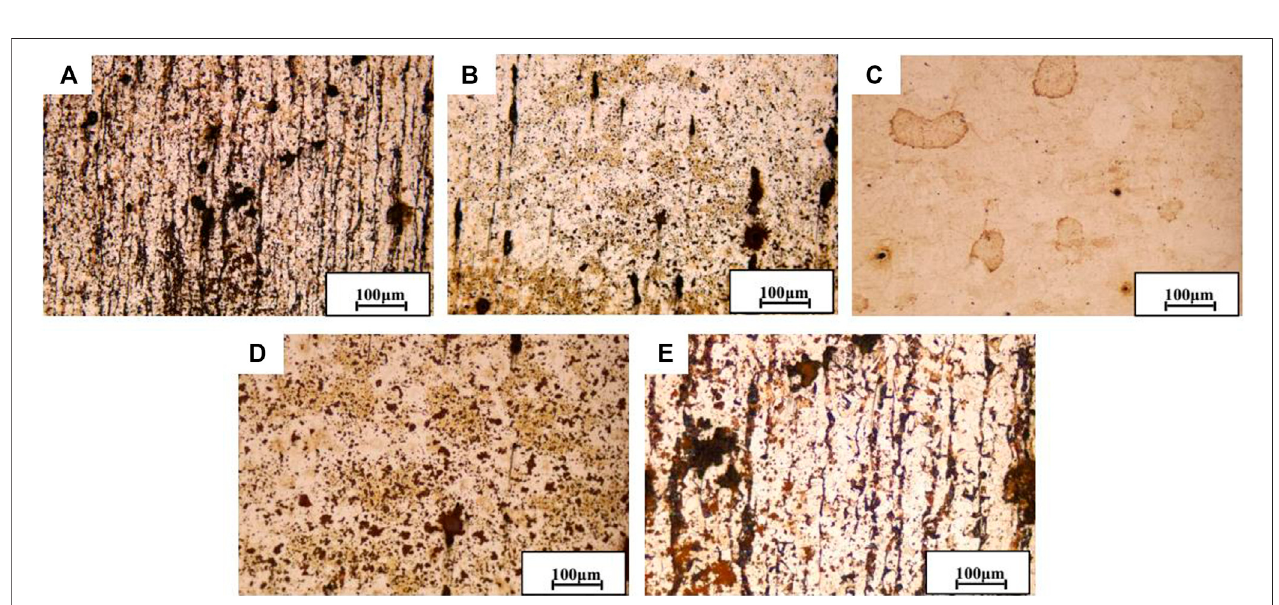
FIGURE 13 | Metallographic images of FSW joint after 24-h immersion in simulated seawater at different areas [ (A) SZ; (B) U-HAZ; (C) WZ; (D) L-HAZ; (E) BMZ].